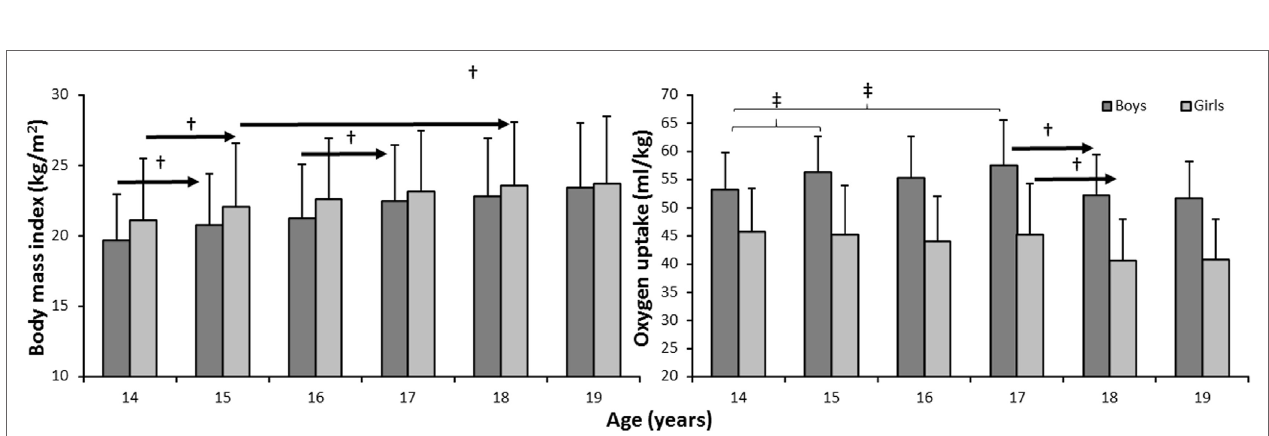
FigUre 4 | Development of body mass and oxygen uptake over the 6 years by gender (boys: n = 29, girls: n = 20). † indicates a significant difference for this gender at a p < 0.05 level between this age and later ages, as indicated by the right-pointing arrow. ‡ indicates a significant difference for this gender between these two ages at a p < 0.05 level.